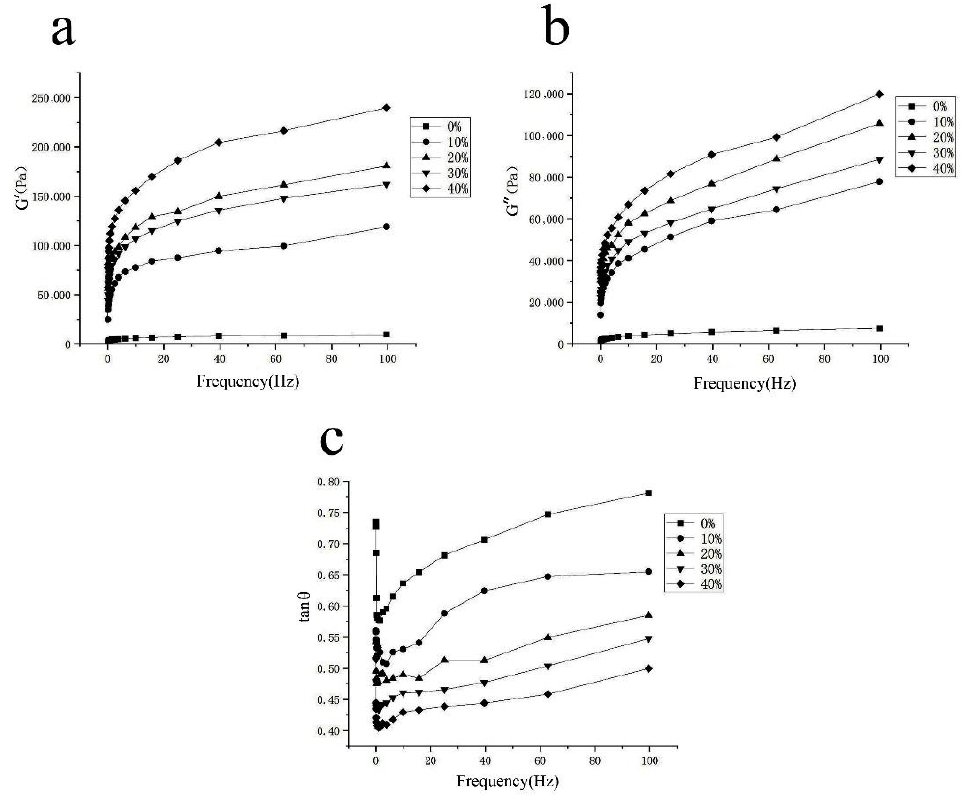
Figure 1. The effect of white kidney bean addition on ( a ) the storage modulus of noodle doughs; ( b ) the loss modulus of noodle doughs; and ( c ) tan δ of noodle doughs.